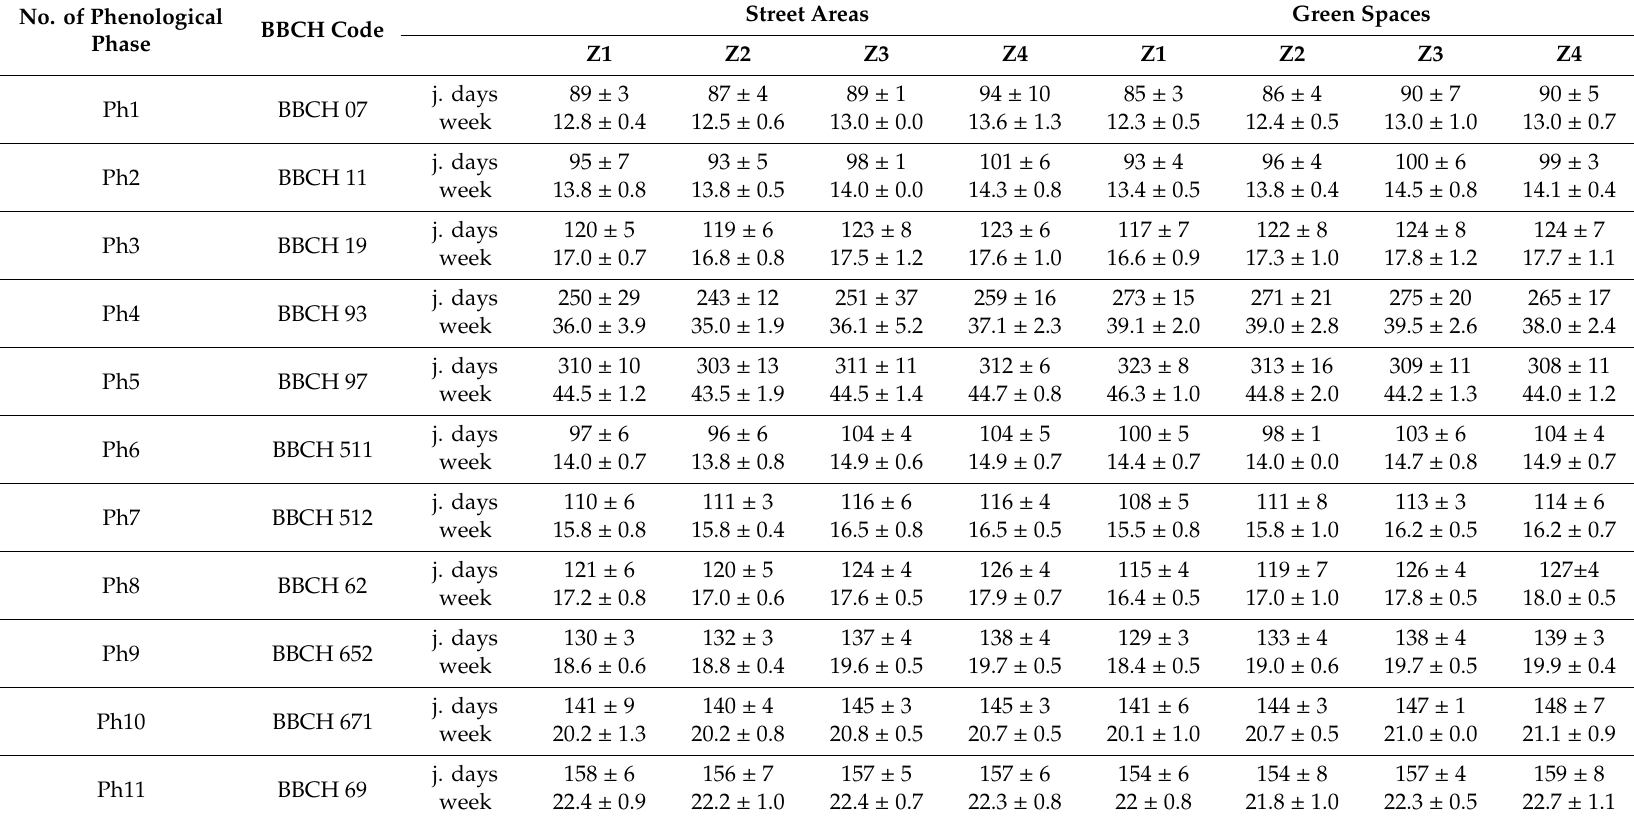
Table 8. Average phenological data ( x ) and variability ( ± SD) in individual groups of land cover forms. taking into account the distance from the center [in weeks and Julian